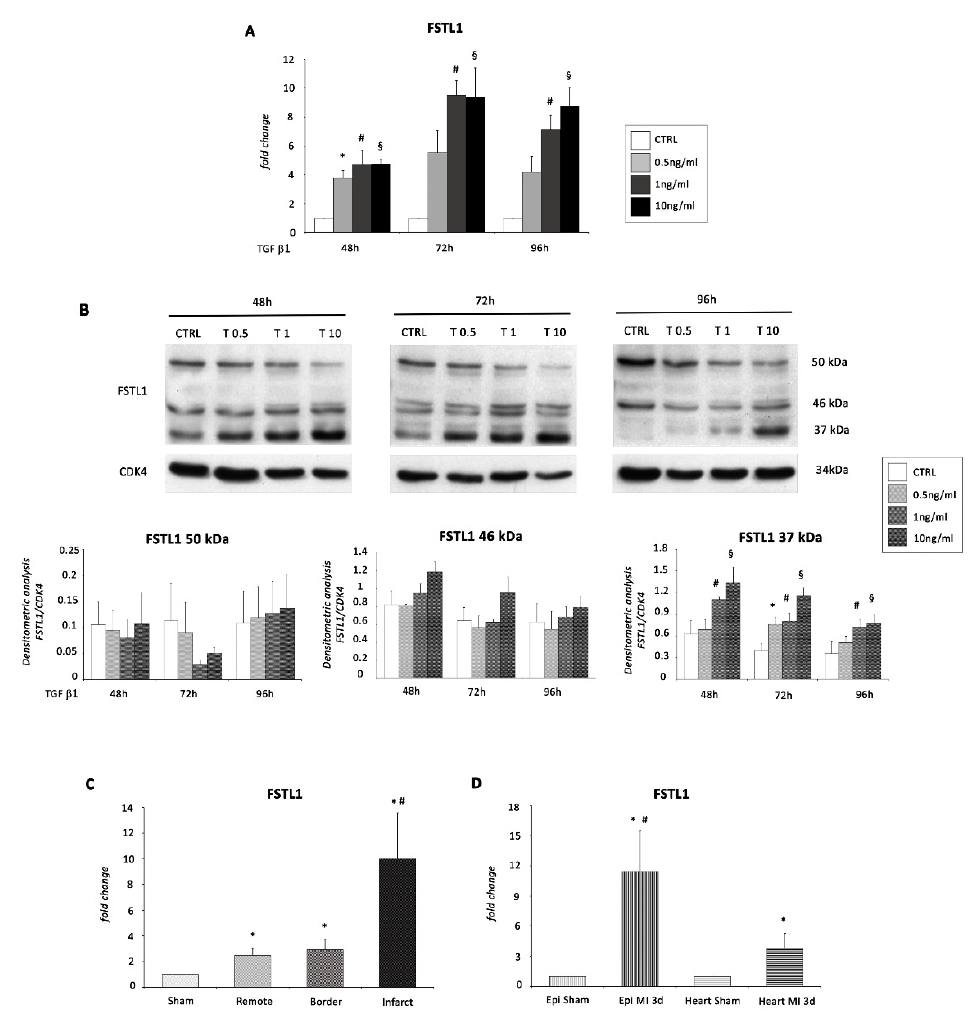
Figure 6. FSTL1 is a potential target of miR-200c. ( A ) mRNA expression and ( B ) protein expression of FSTL1 were deter- mined in EMCs exposed to 48, 72, and 96 h of treatment with TGF β 1 at three different concentrations (0.5, 1, and 10 ng/mL) compared to control conditions (CTRL). ( B ) WB analysis revealed the presence of three bands of approximately 37, 46, and 50 kDa representing the non-glycosylated, lower and higher glycosylated states of the detected FSTL1, respectively. *, p < 0.05 for 0.5 ng/mL of TGF β 1; #, p < 0.05 for 1 ng/mL of TGF β 1; §, p < 0.05 for 10 ng/mL of TGF β 1 vs. control conditions (CTRL). ( C ) FSTL1 mRNA determined by real time PCR in the LV of sham operated mice, in the remote zone, in the border zone and in the infarcted region of three-day infarcted hearts ( n = 3; *, p < 0.05 vs. sham; #, p < 0.05 vs. border). ( D ) FSTL1 mRNA expression determined by real time PCR in epicardial cells and in the myocardial tissue deprived of the epicardium from sham-operated hearts (epi Sham and heart Sham) and infarcted hearts (epi MI 3d and heart MI 3d), 3 days following MI. Data were normalized to GADPH and represent means ± SEM ( n = 3, each n = pool of 6 animals *, p < 0.05 vs. sham. #, p < 0.05 vs. heart MI 3d).